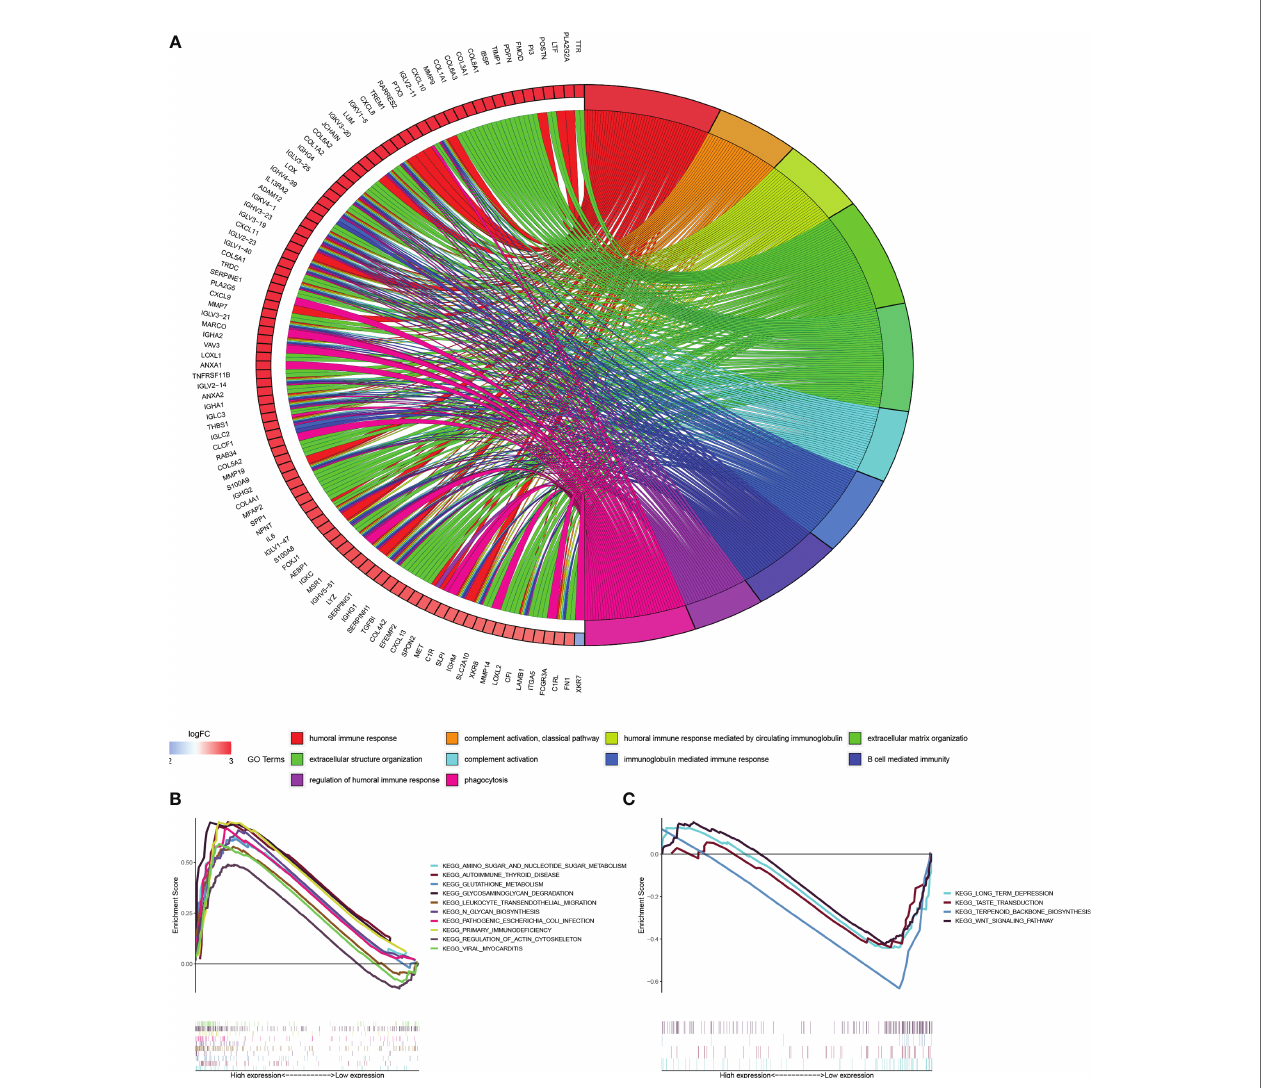
FIGURE 6 | Functional and enrichment pathways analysis. (A) Go circle plot of enrichment analysis based on differently expressed genes between high- and low- risk groups. (B) KEGG pathway enrichment analysis in high-risk group. (C) KEGG pathway enrichment analysis in low-risk